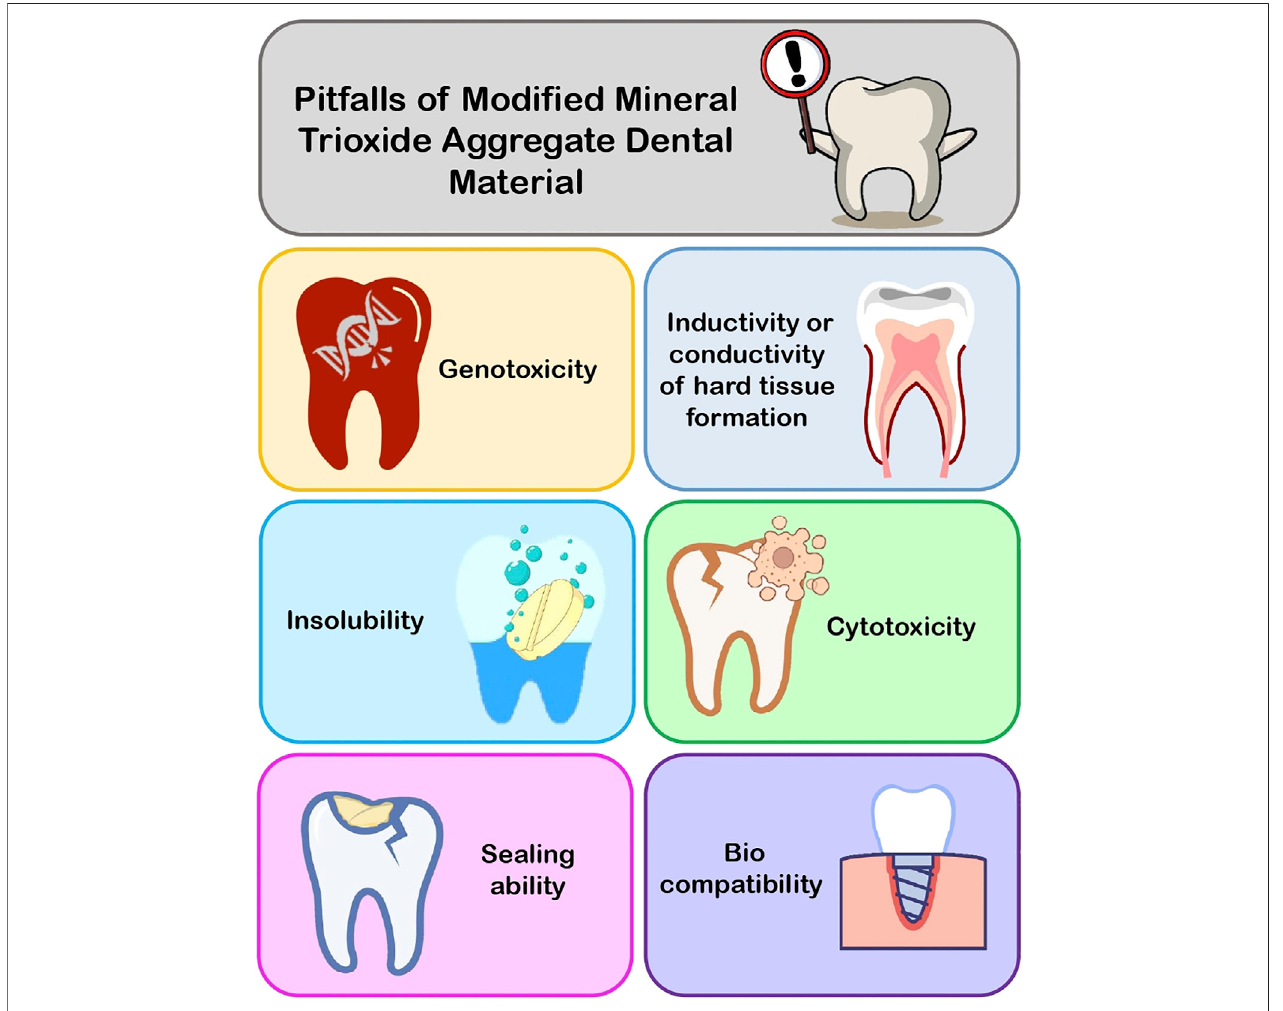
FIGURE 3 | Pitfalls of modi fi ed